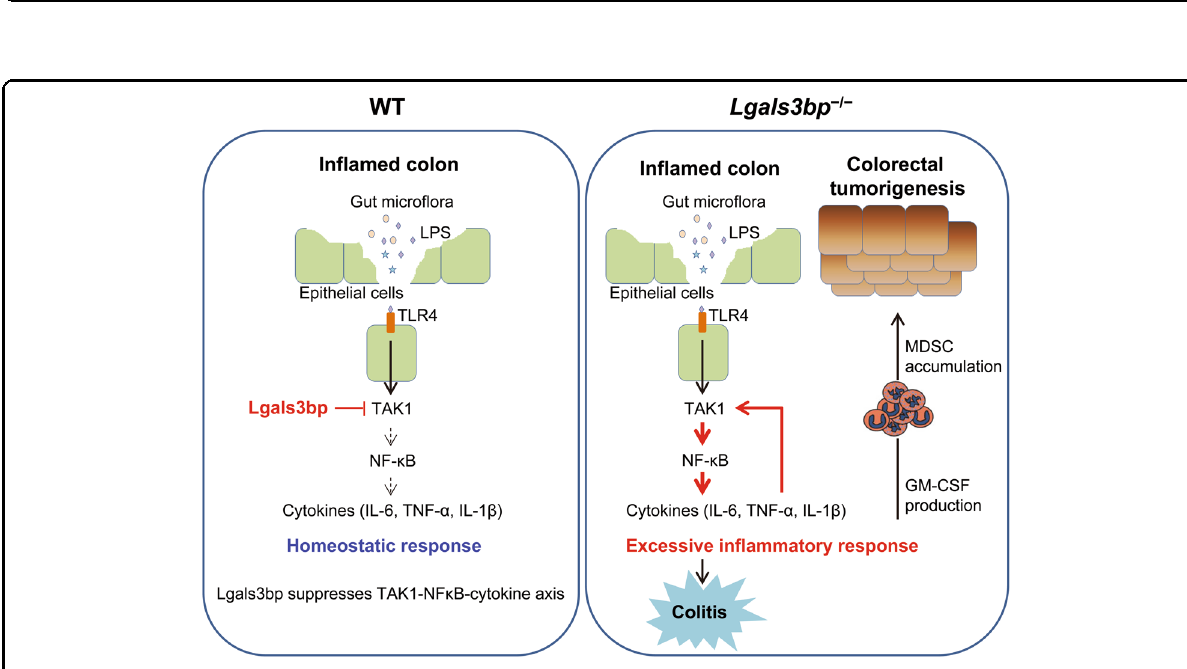
Fig. 7 Schematic of the mechanism showing Lgals3bp-mediated regulation of colon in fl ammation and tumorigenesis. (1) A colonic in fl ammatory microenvironment is mediated by the TAK1-NF- κ B-cytokine axis. Lgals3bp negatively regulates in fl ammatory responses via the downregulation of the TAK1-NF- κ B-cytokine axis in colon epithelial cells. Therefore, Lgals3bp regulates colon homeostasis. (2) Lgals3bp − / − mice exhibit severe colitis because of excessive pro-in fl ammatory cytokine production. Furthermore, Lgals3bp − / − mice exhibit severe colon tumorigenesis via GM-CSF-mediated MDSC